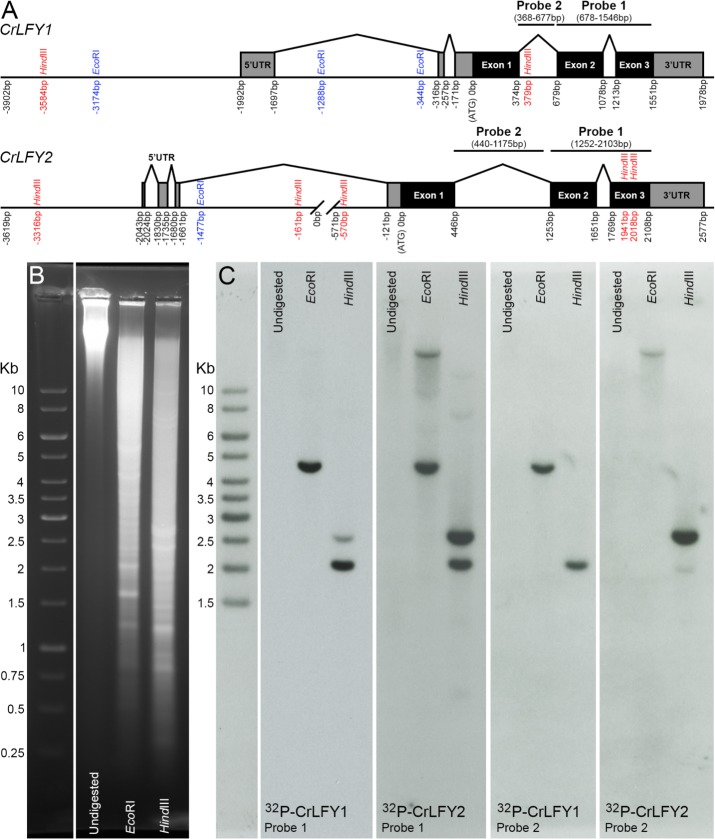
The Ceratopteris genome contains only two copies of LFY.(A) Deduced gene structure of CrLFY1 and CrLFY2 loci. All positions marked are given relative to the ATG start codon. Hybridization probes used in DNA gel blot analysis and relevant restriction sites (EcoRI, HindIII) are marked. CrLFY1 probe 1 (868bp) and CrLFY2 probe 1 (851bp) share 79% sequence similarity and hybridize to exons 2 + 3 of each gene (comprising the conserved LFY DNA binding domain). As such, both probes should hybridize to all members of the LFY gene family. CrLFY1 probe 2 (309bp) and CrLFY2 probe 2 (735bp) hybridize to intron 1 of each gene copy and share no significant sequence similarity. As such, each probe is expected to hybridize to the specific gene copy. (B, C) Gel blot analysis of wild-type genomic DNA, digested with EcoRI or HindIII, electrophoresed on an ethidium bromide stained gel (B), blotted to nylon membrane and hybridized against different probes (C) as described in (A). EcoRI digestion was predicted to generate single hybridizing fragments for both CrLFY1 and CrLFY2, each spanning both probes with minimum expected fragment sizes of ~2.0 kb and ~3.1 kb, respectively. HindIII digestion was predicted to generate a single CrLFY1 hybridizing fragment recognized by both probes with a minimum size of ~1.6 kb. HindIII digestion was predicted to generate a CrLFY2 fragment of ~2.5 kb hybridizing to probes 1 and 2, a separate fragment with a minimum size of 559 bp overlapped by 85 bp of probe 1 (and so potentially undetectable) plus an undetectable fragment of 11 bp. The hybridization patterns observed (C) are consistent with these predictions, with the exon probes cross-hybridizing to predicted fragments of both gene copies (but not to any additional gene fragments) and the intron probes primarily hybridizing to the respective specific gene copy.